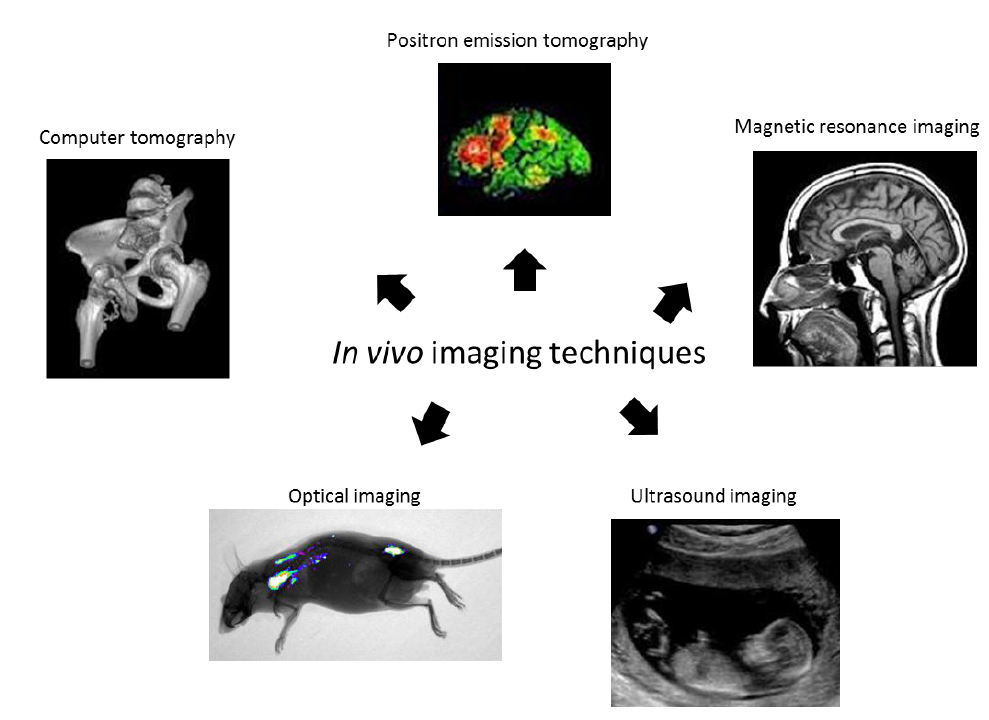
Figure 1. Main in vivo imaging